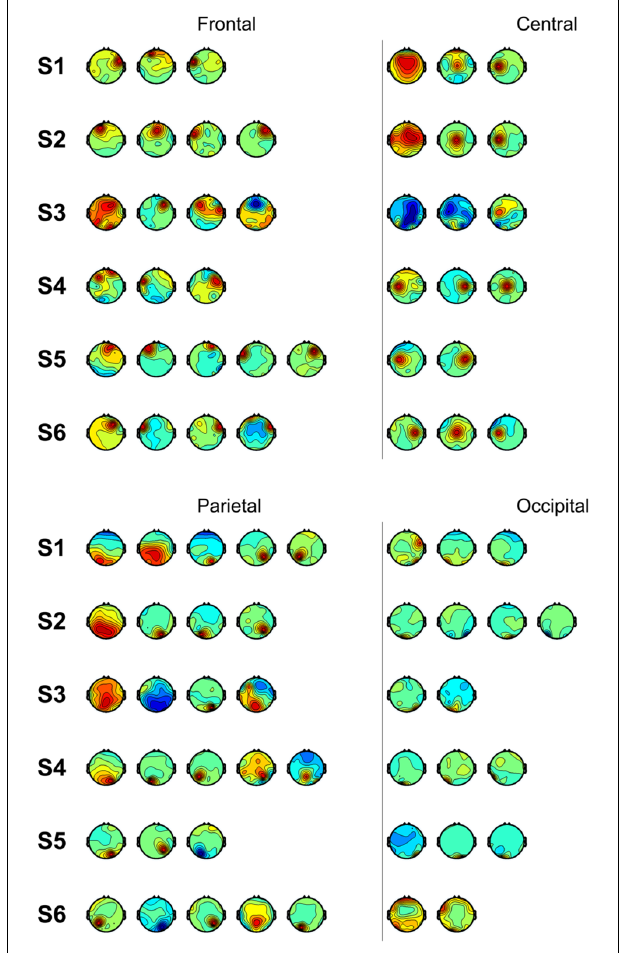
FIGURE 4 | Scalp maps of independent components categorized according to area of peak activity for all subjects (control).